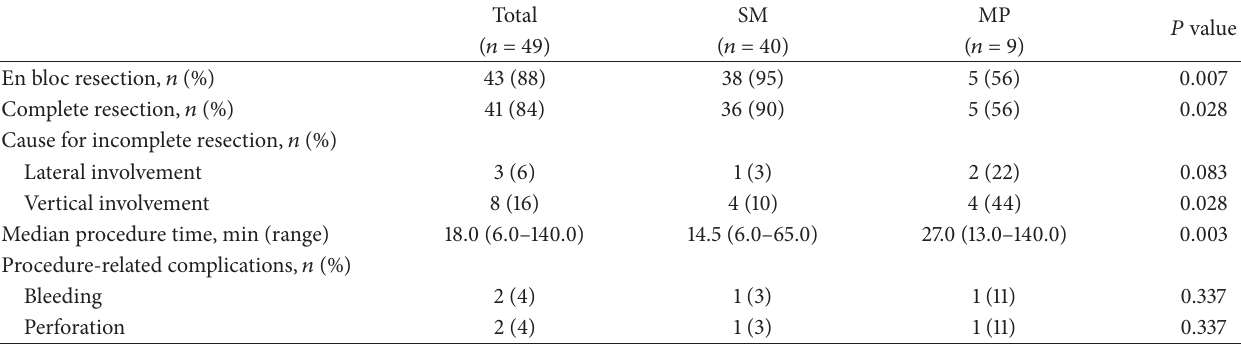
Table 2: Therapeutic outcomes of endoscopic submucosal dissection for gastric subepithelial tumors according to the layer of tumor origin. Total